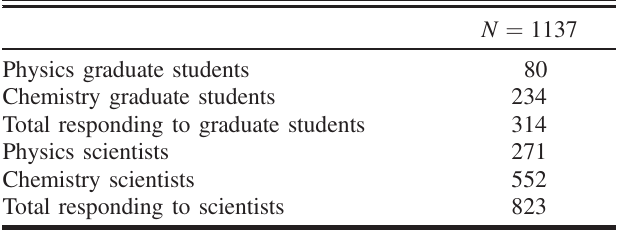
TABLE I. A summary comparison of the sample of female physical graduate students and